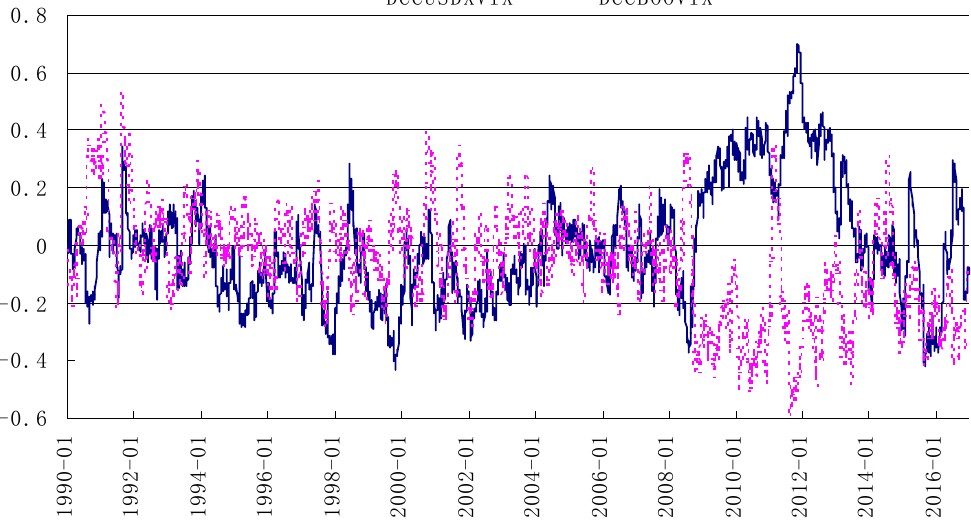
Figure 5. The DCC coefficients between VIX with dollar index and Brent crude oil.